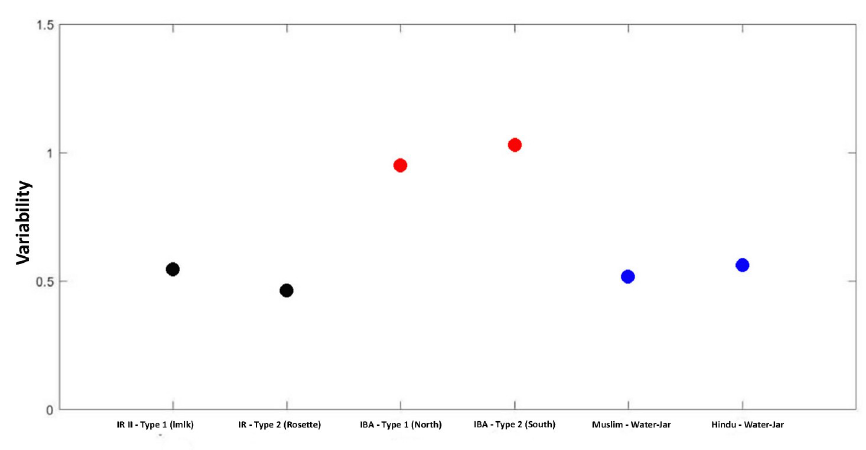
Fig 12. The variability degree of three datasets: The IR II ( lmlk and Rosetta jars–black dots); the IBA jars (North and South–red dots); and the ethnographic reference data (Muslim and Hindu production–blue dots).